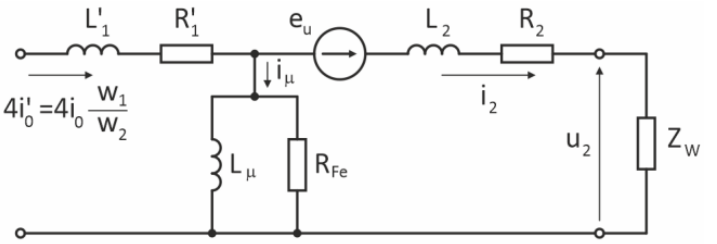
Figure 2. The equivalent diagram of the summation current transformer which takes into account the influence of the error voltage on the transformation.